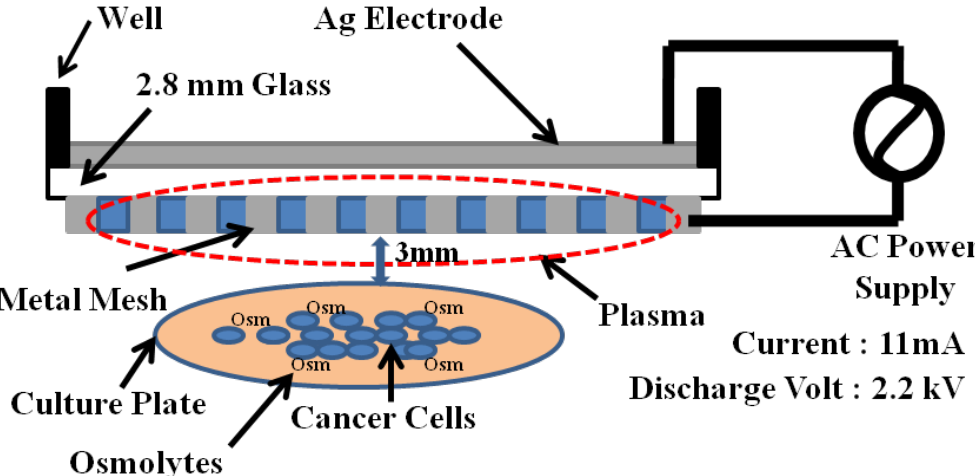
Figure 2. Schematic diagram of dielectric barrier discharge plasma system consisting mainly of a high-voltage power supply, electrodes, and dielectrics.